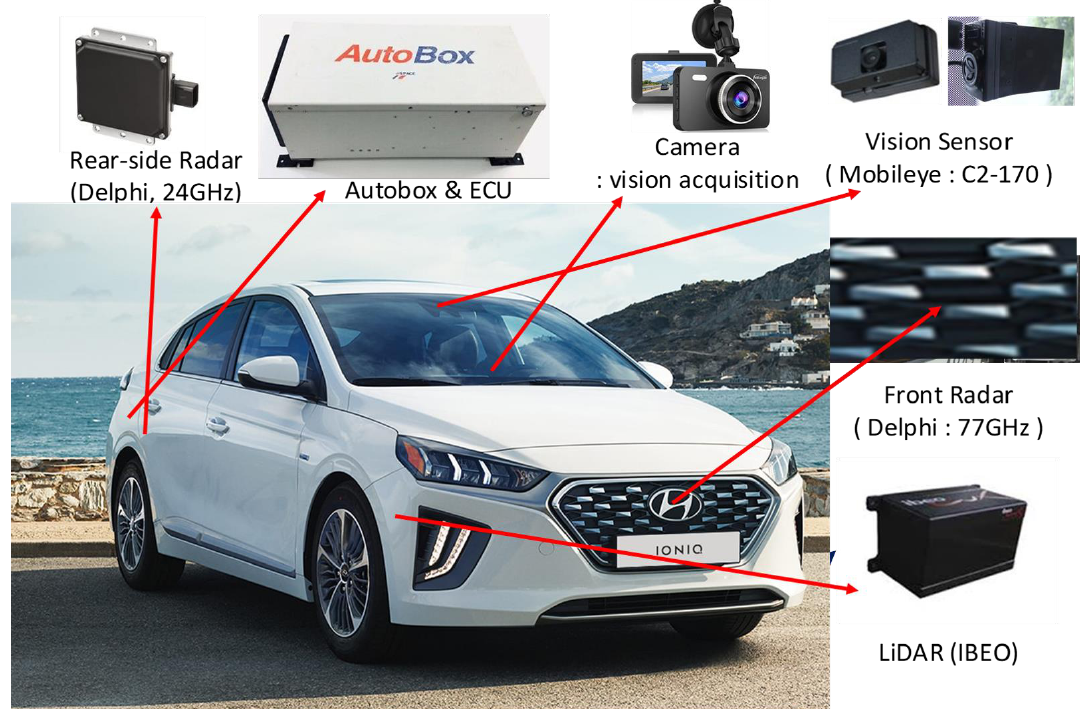
Figure 9. Test vehicle sensor configuration.